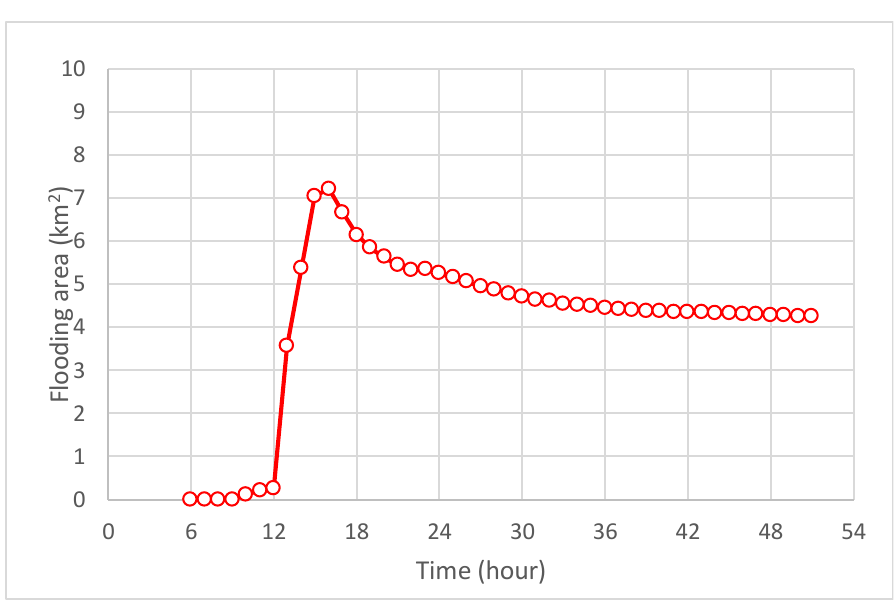
Figure 17. Resulting flood map from the SOBEK model in study area Miaoli City.